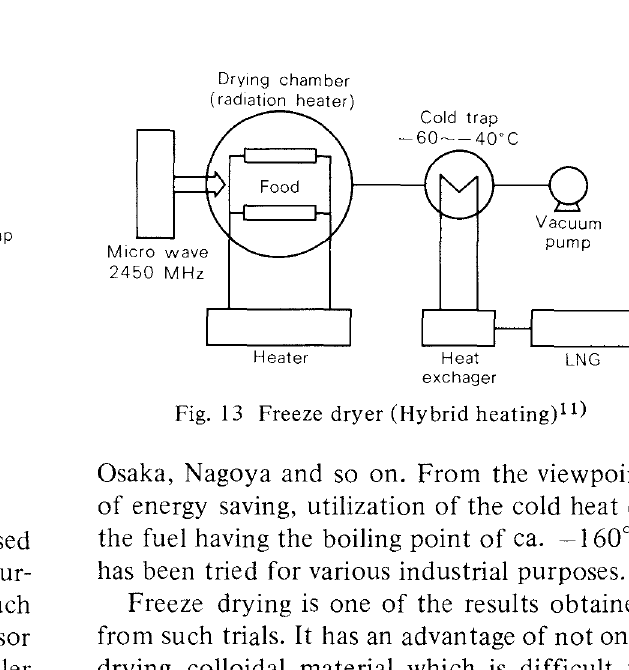
Fig. 12 Dryer using heat pump1 1) Fig. 13 Freeze dryer (Hybrid heating)